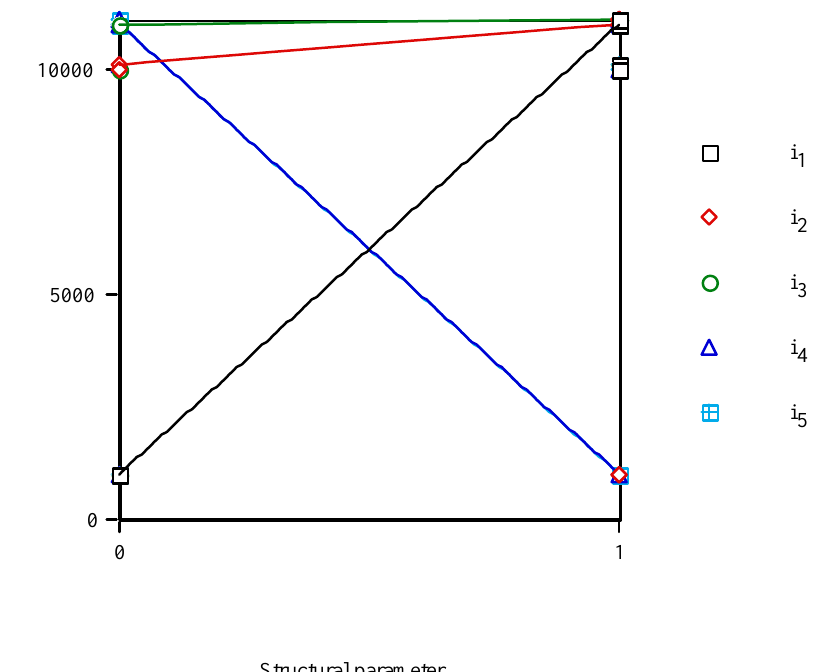
Figure 9. Variation of the vector property of local anaesthetics vs . counts { i The variation of the vector property P = < i PT ( cf . Figure 10) for local anaesthetics, reveals that the minima correspond to anaesthetics with , i , i } values of <010> (group g010). The corresponding function P ( i { i 1 2 3